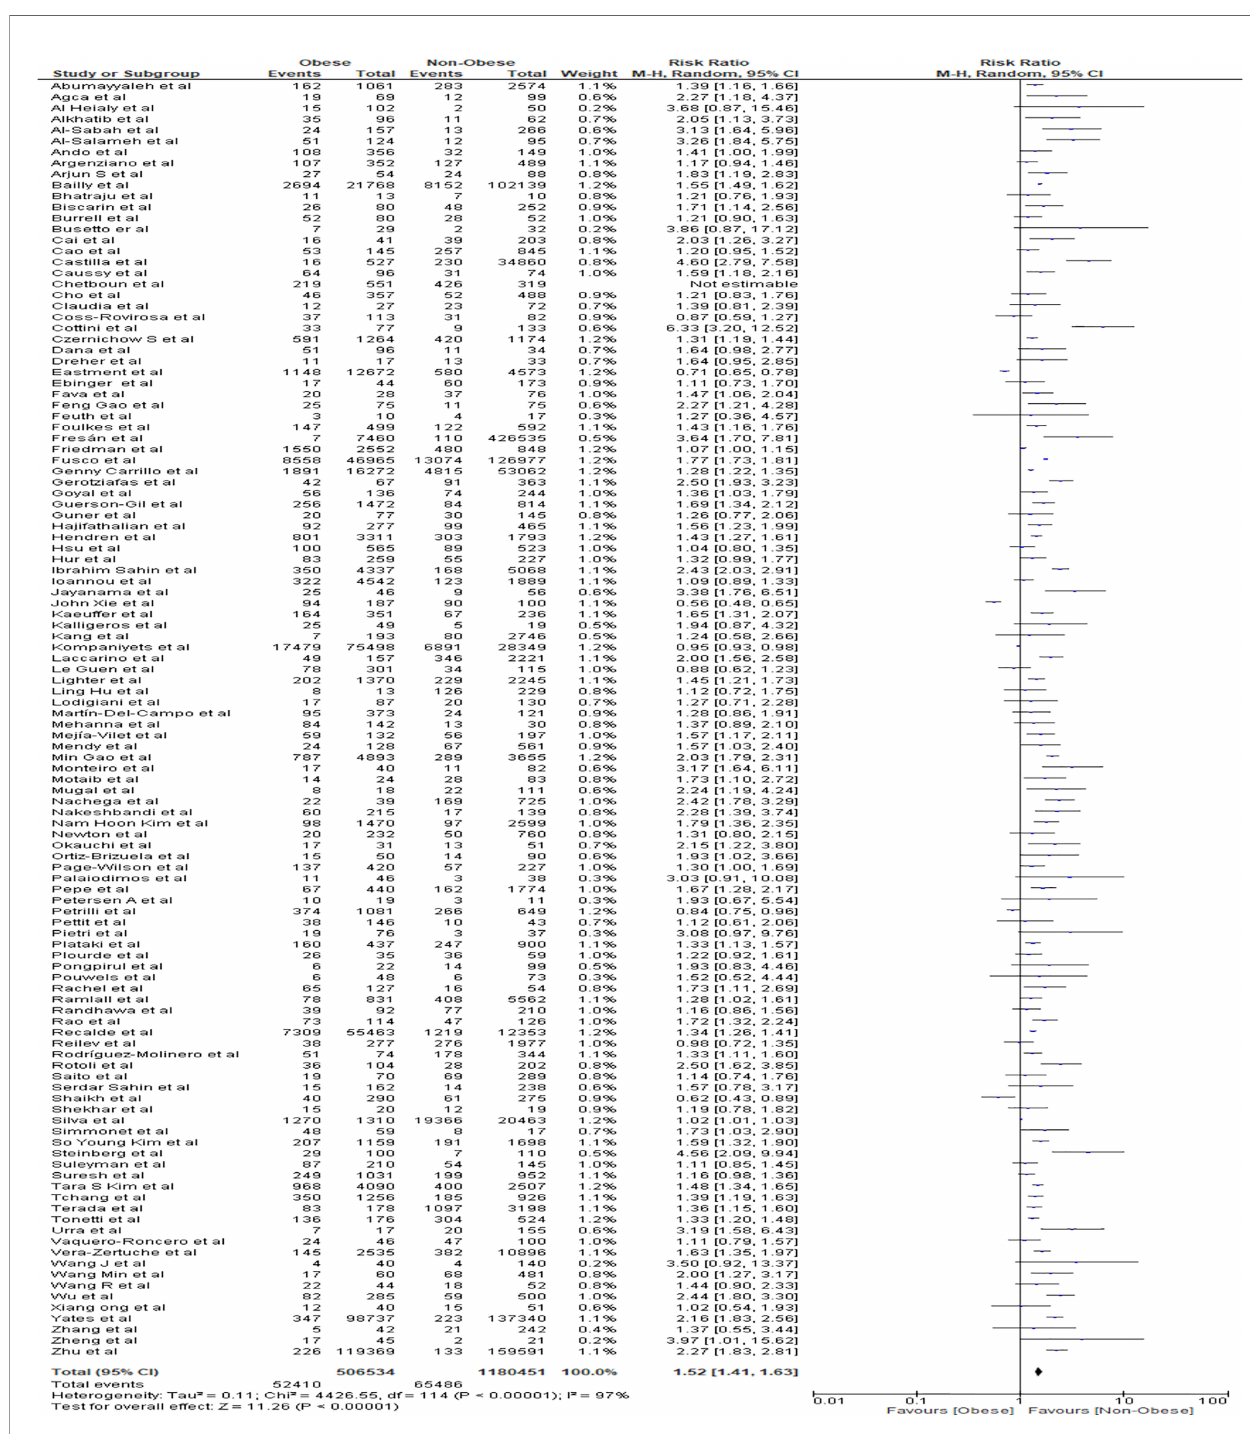
FIGURE 2 | Forest plot for severity